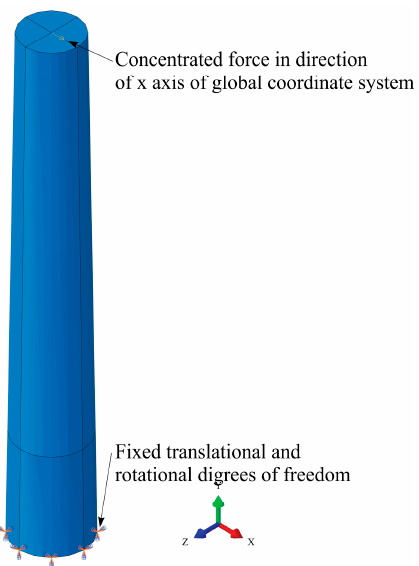
Figure 12. The geometry and boundary conditions of the cantilever beams.